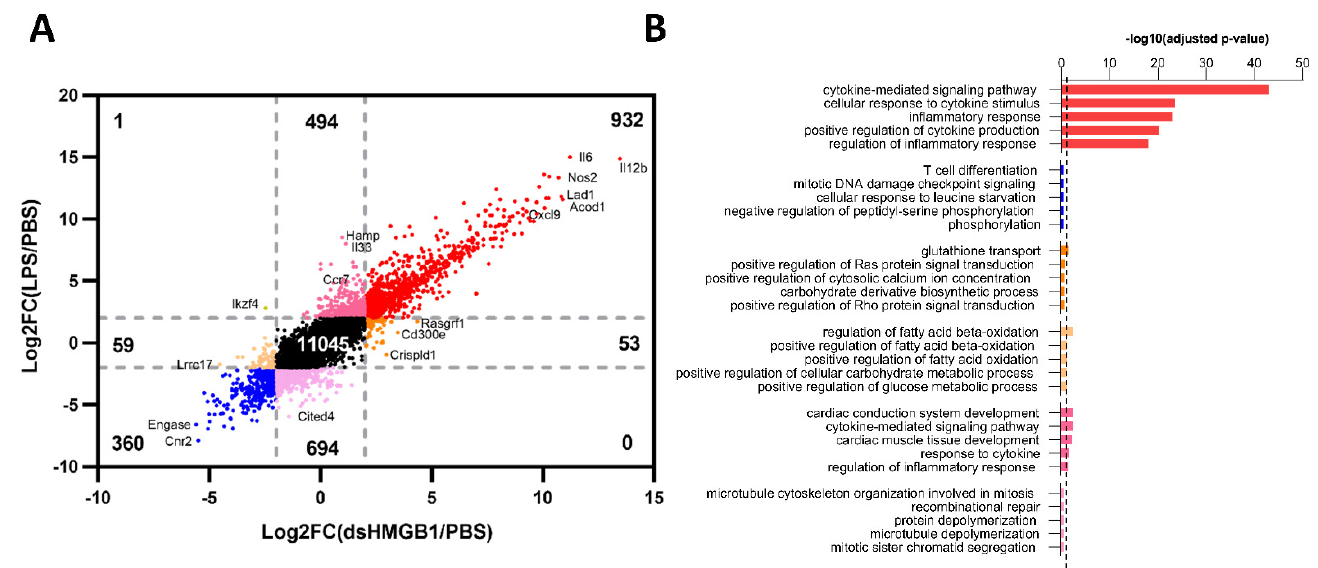
Figure 4. Comparison of common and distinct genes of LPS- and dsHMGB1-stimulated BMDMs. ( A ) Log2FoldChange (Log2FC) vs. Log2FC plot of dsHMGB1 vs. control on the x -axis and LPS vs. control on the y -axis highlighting common upregulated genes in red (932 genes), common downregulated genes in blue (360 genes), LPS up- and dsHMGB1 downregulated genes in dark yellow (1 gene), dsHMGB1-distinct genes in orange (112 genes) and M1-distinct genes (1188 genes) in pink. Grey dotted lines represent a ±2 cut-off. ( B ) GO analysis on six gene sets; only the top five enriched biological processes are presented, sorted by p -value. The scatter line indicates the cut-off p -value 0.05.